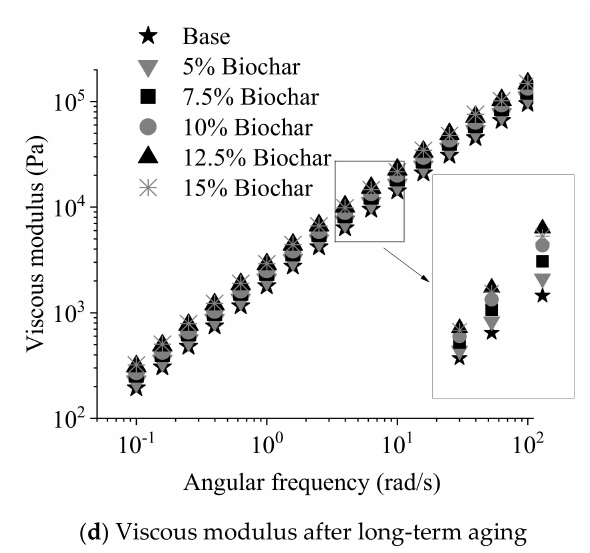
Figure 7. Influence of loading frequency on dynamic shear modulus of binder under di ff erent aging conditions.